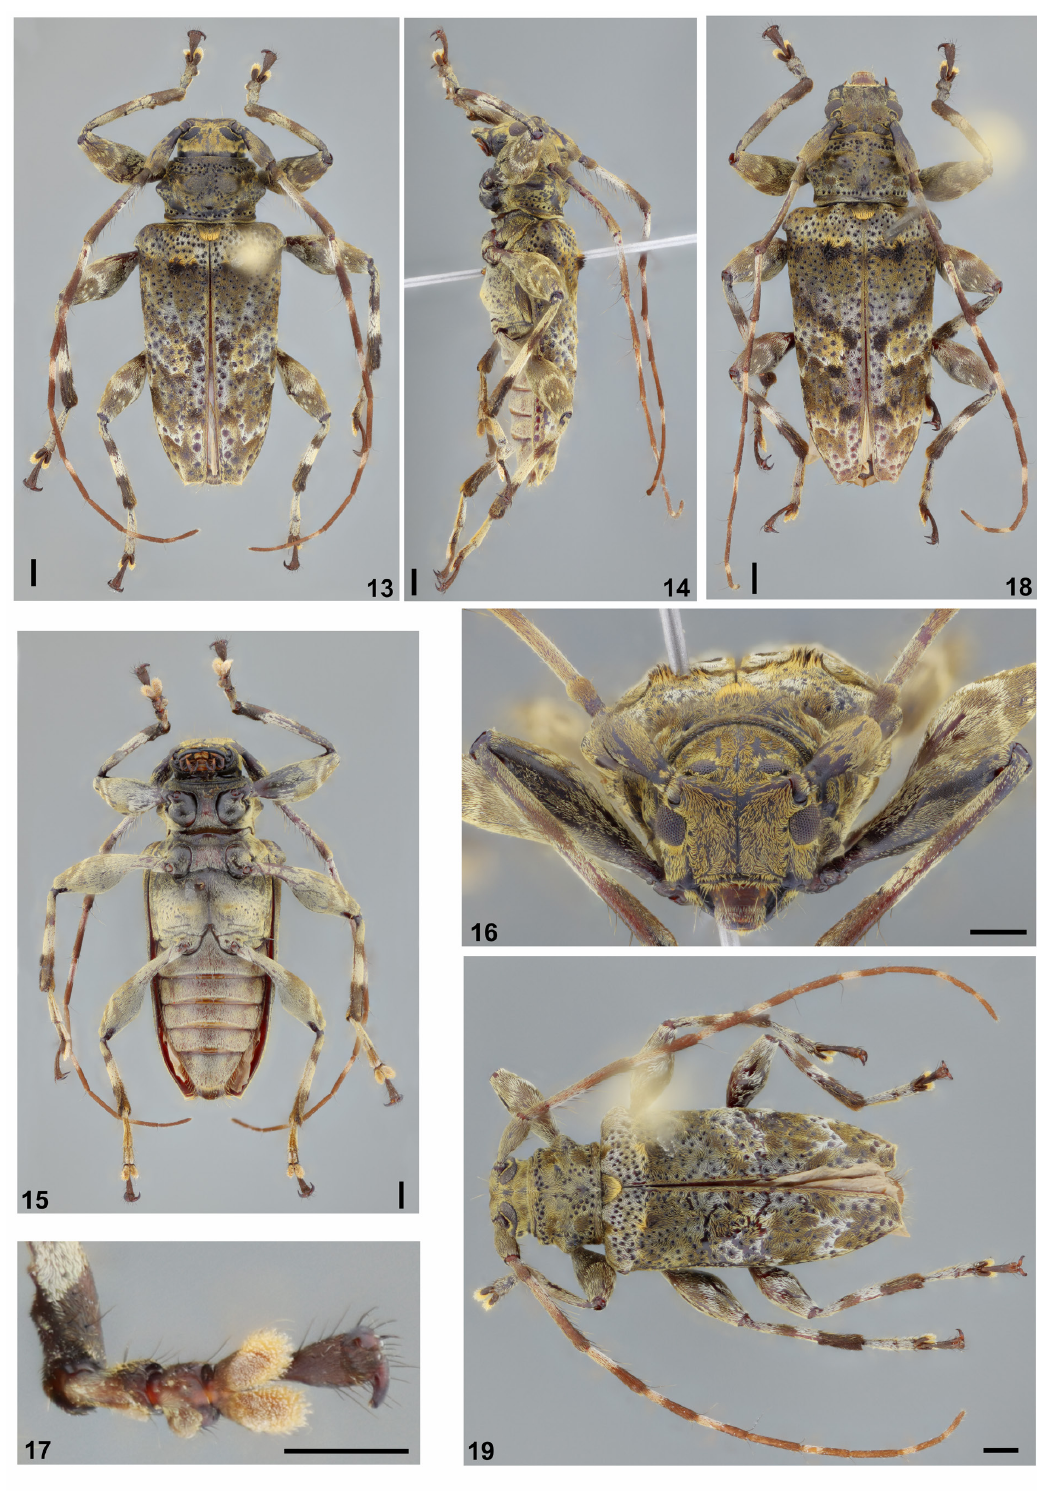
Figs 13–19. Oreodera kawasae sp. nov. 13–17 . Holotype, ♂ (RBINS 34.248). 13 . Habitus, dorsal view. 14 . Habitus, lateral view. 15 . Habitus, ventral view. 16 . Head, frontal view. 17 . Protarsus. 18–19. Male paratypes, dorsal habitus. 18 . Specimen 1 (MZSP), habitus, dorsal view. 19 . Specimen 2 (MZSP), habitus, dorsal view. Scale bars = 1.0